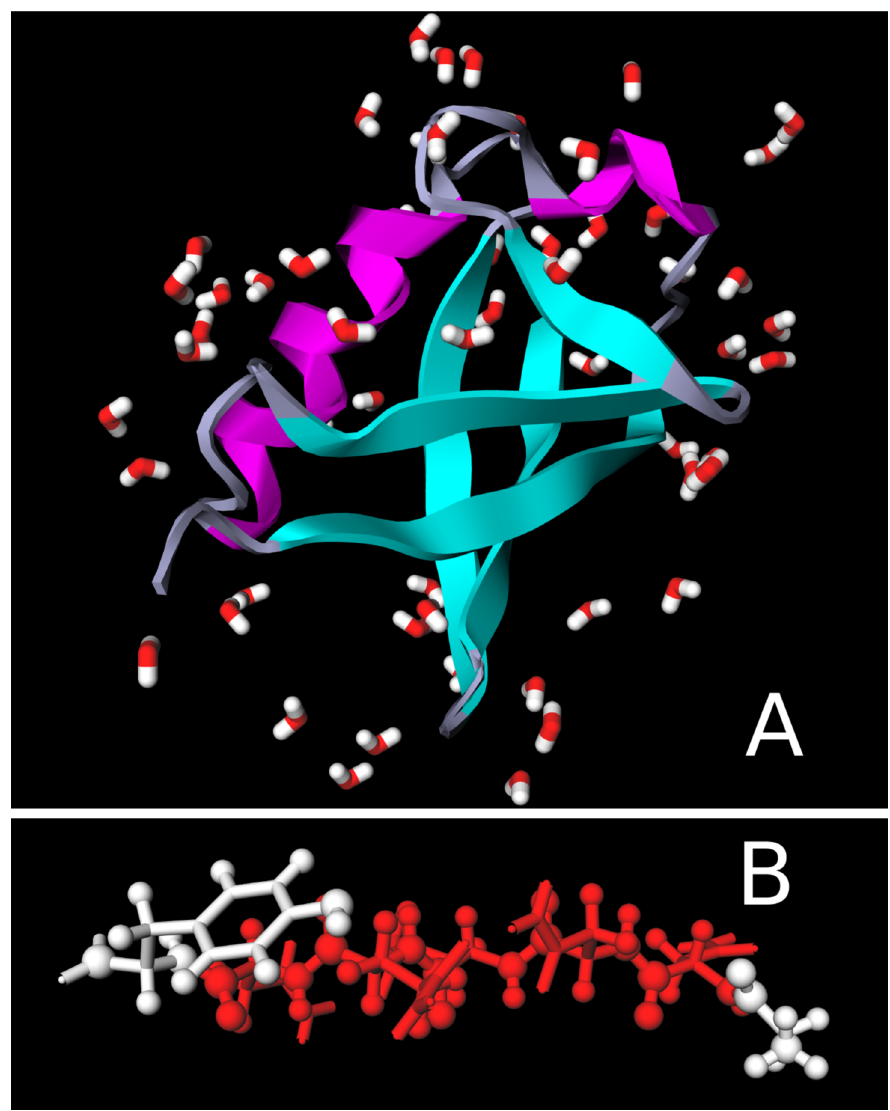
Figure 3. Examples of using GLmol for visualization. (A) Ubiquitin (PDB code 1UBQ [57]) displayed as ribbons with crystal waters. (B) A ball- and-stick representation of a small peptide (PDB code 1YJP [27]).